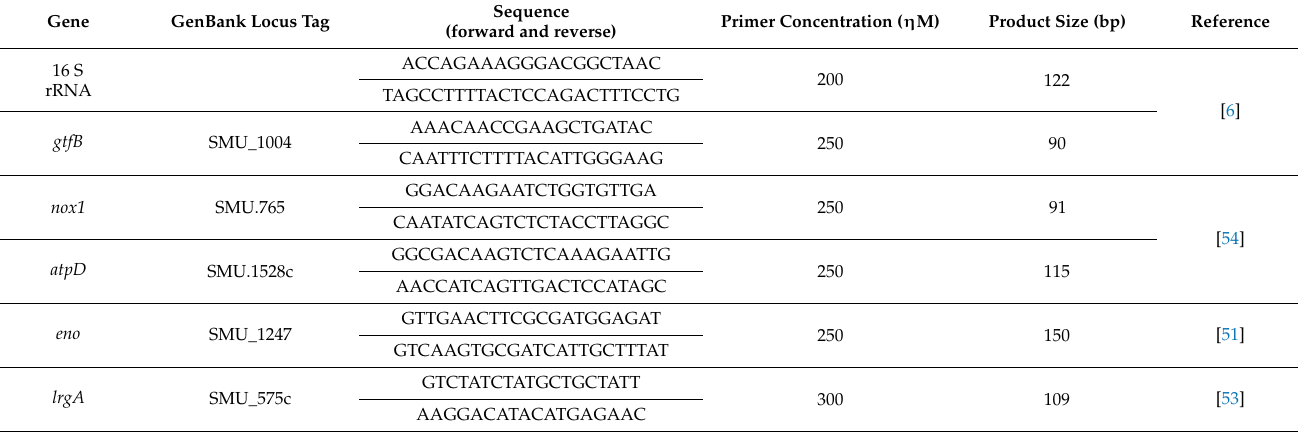
Table 5. Primers used for